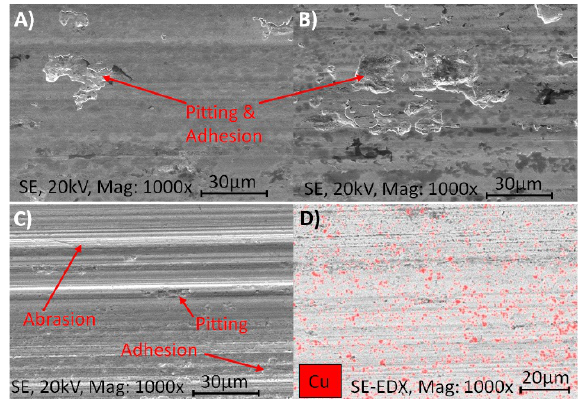
Figure 7. Scanning electron microscope image including element analysis about the worn disc surfaces,